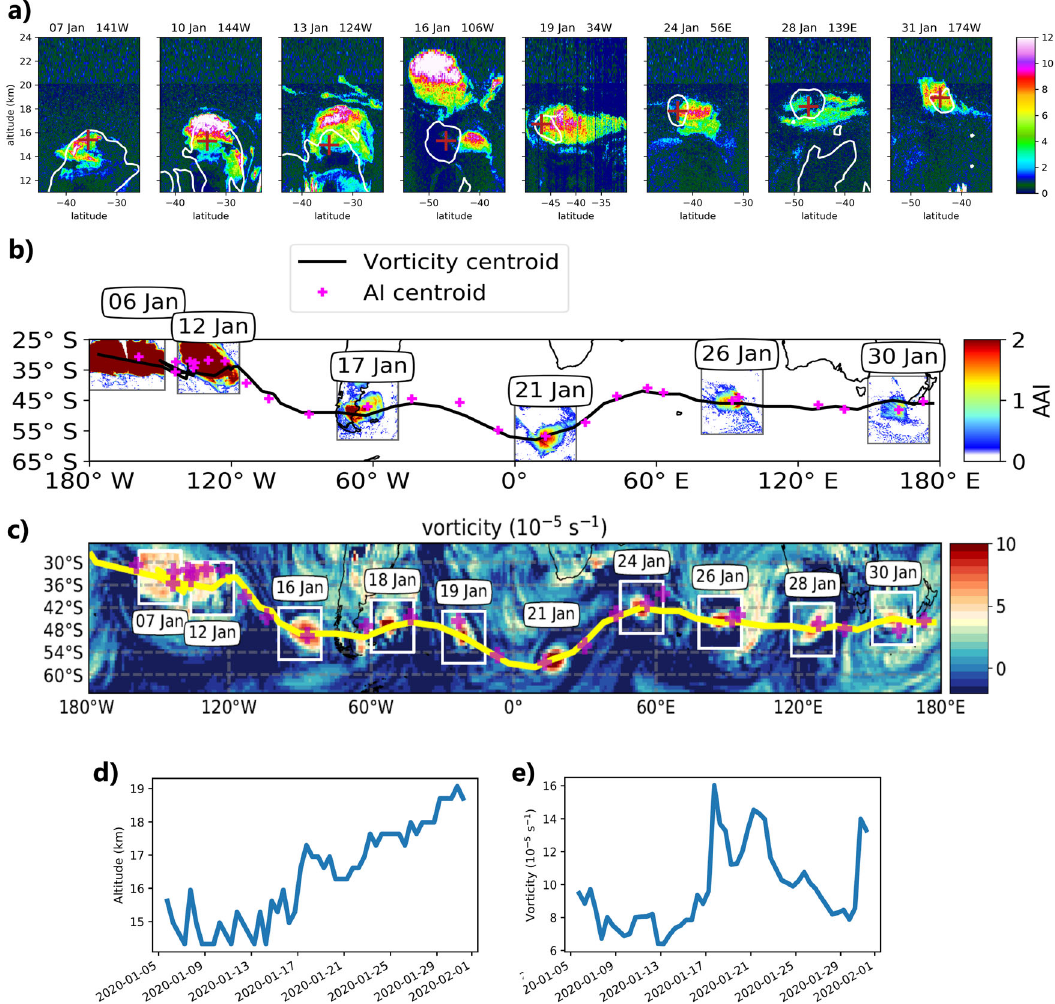
Fig. 8 Spatiotemporal evolution of the second vortex. a Time evolution from eight matching sections of CALIOP. b Composite of TROPOMI aerosol index (AI) at the location of the vortex for six dates that do not necessarily match that of CALIOP. c Time evolution of the vortex according the ECMWF analysis from ten vorticity snapshots at the level of maximum vorticity. The background is shown for 24 January. In b , c the trajectory of the AI centroid is shown as magenta crosses and the trajectory of the IFS vortex is shown as the black and yellow curves, respectively. d Altitude of the vortex core as a function of time. e Maximum vorticity at the vortex core as a function of